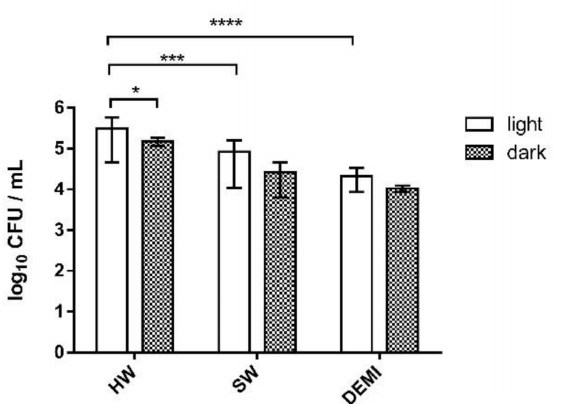
Figure 8. Adhesion of L. pneumophila to polystyrene in water samples of different hardness (HW, SW, and DEMI) after irradiation with violet light for 10 min (395 nm, total light dose 12 J/cm 2 ) (=“light”) and without irradiation (=“dark”). All results are shown as an average of triplicate measurements and error bars presenting SD; **** p < 0.0001, *** 0.0001 < p < 0.001, * 0.01 < p <